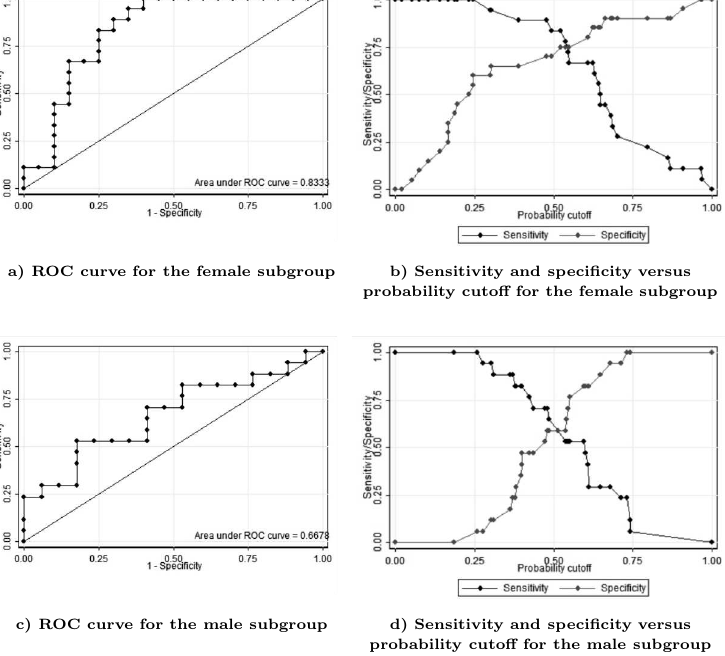
Figure 4. Classification quality